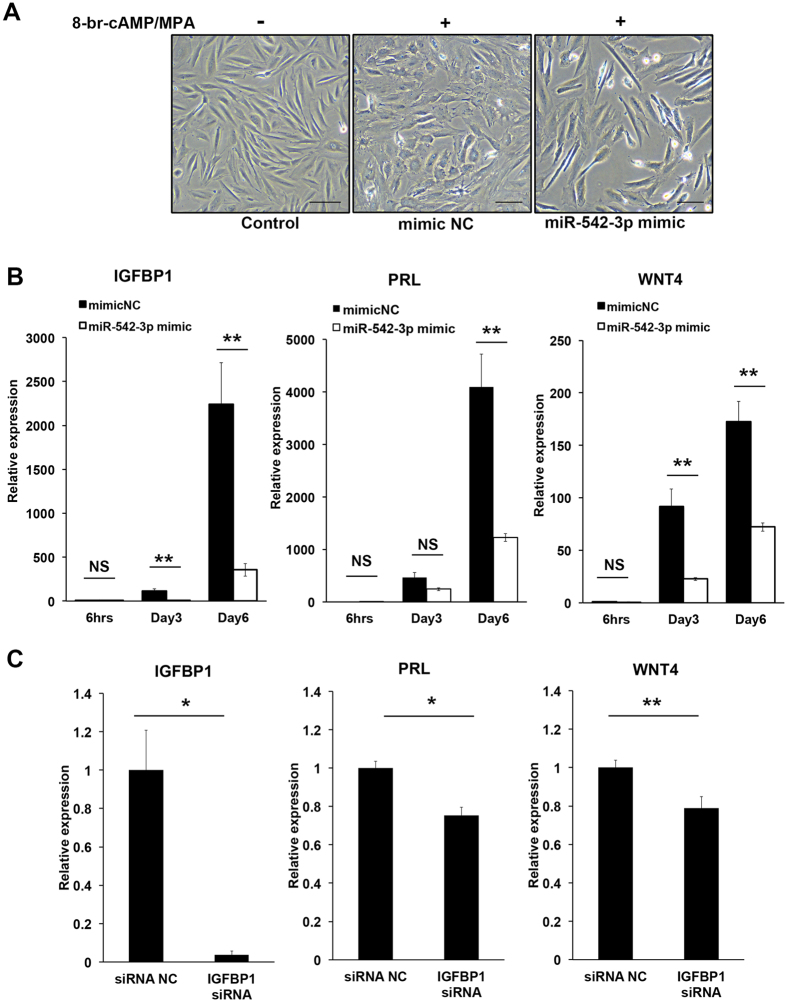
Effect of miR-542-3p overexpression or IGFBP-1 knockdown in decidualizing HESCs.(A) Morphological changes of HESCs transfected with miR-542-3p mimic. HESCs transfected with negative control miRNA mimic (NC mimic) showed morphological changes characteristic of decidual cells upon treatment with 8-br-cAMP and MPA for 6 day. By contrast, morphological transformation was absent upon transfection of cells with miR-542-3p mimic. Scale bars = 100 μm. (B) qRT-PCR analysis of IGFBP1, PRL and WNT4 transcript levels in HESCs transfected with a miR-542-3p mimic or NC mimic and decidualized for. 6 days. Expression levels were normalised to GAPDH. Data represent mean ± SEM of three independent experiments. (C) qRT-PCR analysis IGFBP1, PRL and WNT4 transcript levels in HESCs transfected with siRNA targeting IGFBP-1 and then decidualized for 6 days. Expression levels were normalised to GAPDH. Data are the mean ± SEM of three independent experiments **P < 0.01, *P < 0.05.